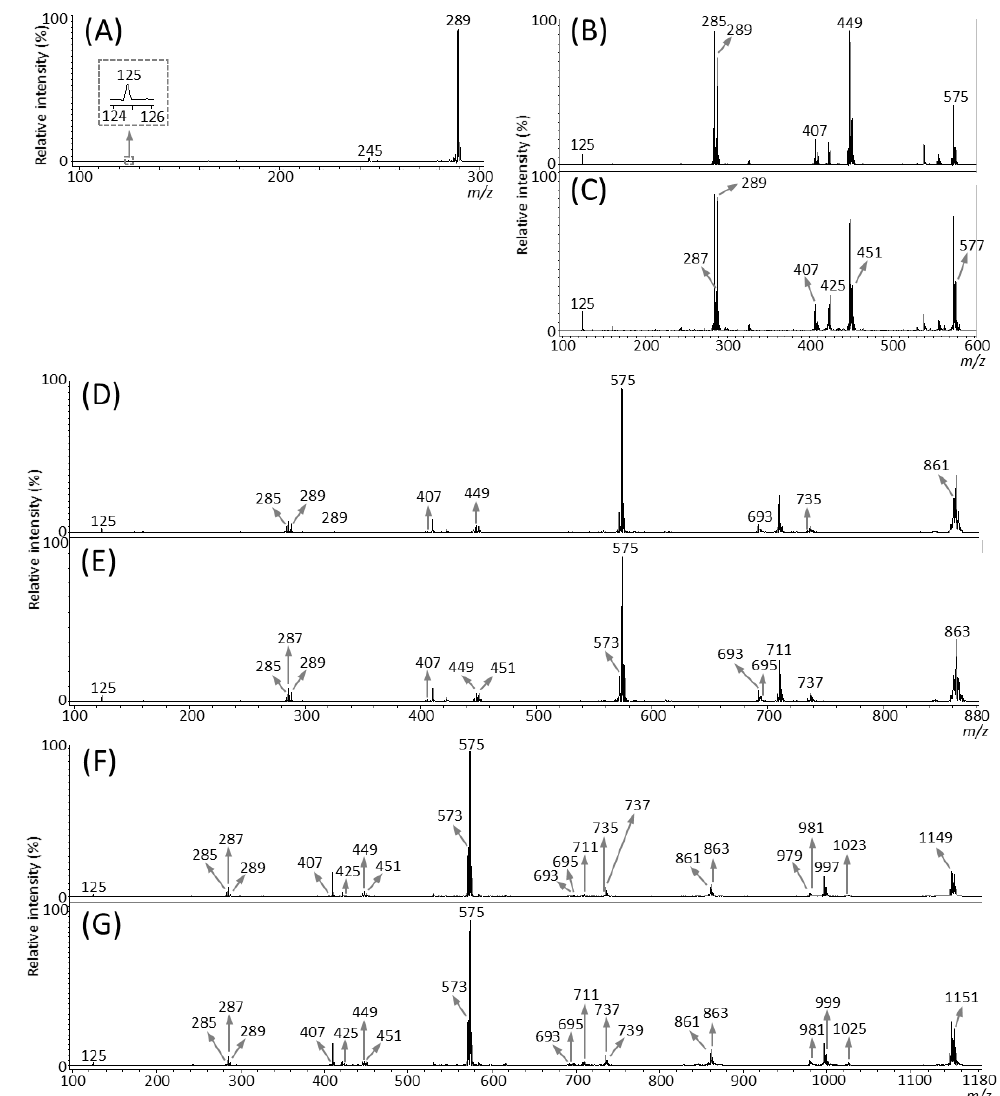
Figure 4. Matrix-assisted laser desorption / ionization (MALDI)-tandem mass spectrometry (MS / MS) analysis of a peanut section. MALDI-MS / MS spectra were obtained from the outer epidermis of the testa of the peanut section after MALDI-mass spectrometry imaging. Representative MS / MS spectra of precursor [M − H] − ions at m / z ( A ) 289.1, ( B ) 575.1, ( C ) 577.1, ( D ) 861.2, ( E ) 863.2, ( F ) 1149.3, and ( G ) 1151.3. The fragment ion peaks with m / z values generated by retro-Diels-Alder (RDA), heterocyclic ring fission (HRF), and quinone methide (QM) reactions were used for molecular assignments.